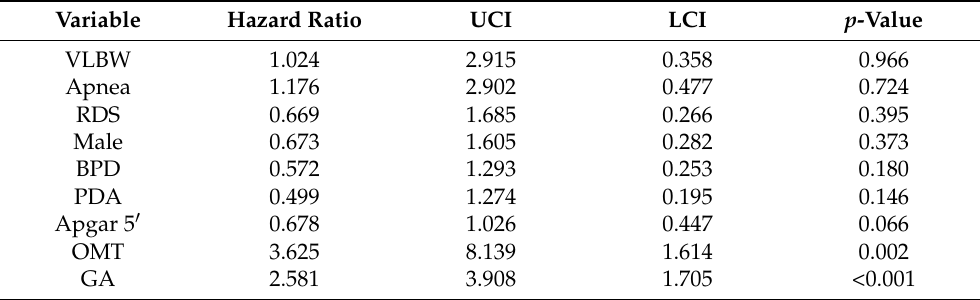
Figure 1. Distribution of cumulative incidence function of NIV weaning in infants stratified by OMT exposure. Table 2. Multivariate Cox regression of time of independent ventilation function.